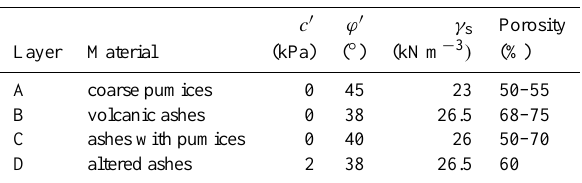
Fig. 1. The instrumented slope of Cervinara: (a) plan view with in- dication of the monitoring station and of the 1999 landslide limit; (b) an example of the layered profile of the soil cover as found in a pit close to the monitoring station; (c) sketch of the installed instru- ments and of the soil profile at the field monitoring station. Table 1. Main physical properties of the soils constituting the cover: c 0 – effective cohesion; ϕ 0 – effective friction angle; γ s – specific unit weight.